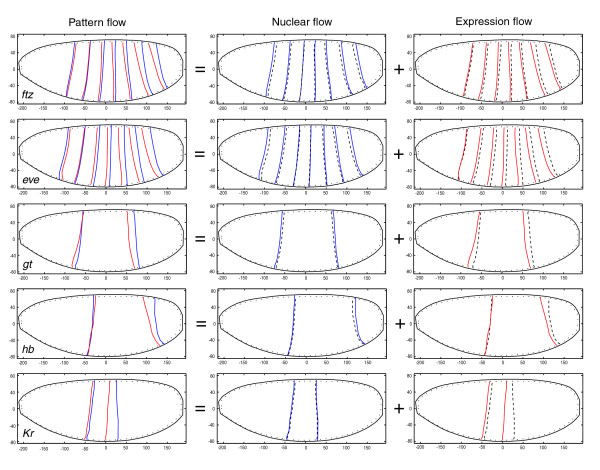
The relative contributions of nuclear flow and expression flow to pattern flow. Orthographic projections of the locations of ftz, hb, eve, gt, and Kr stripe borders in early stage 5 (blue lines) and late stage 5 (red lines) embryos. The stripe locations are taken from the earliest and latest applicable embryo cohort (5:4-8% to 5:75-100% for ftz and eve; 5:0-3% to 5:51-75% for hb, gt and Kr). The axes are labeled as in Figure 4. Our model of nuclear flow was used to predict the location of stripe borders in late embryos in the absence of changing expression levels (dotted black lines). The left panels compare the measured locations of the early and late stripe borders, and thus show the pattern flow. The center panels show the movement predicted to be due only to nuclear flow. The right panels show the residual movement (expression flow) that can be attributed to zones of up/down-regulation along stripe boundaries.